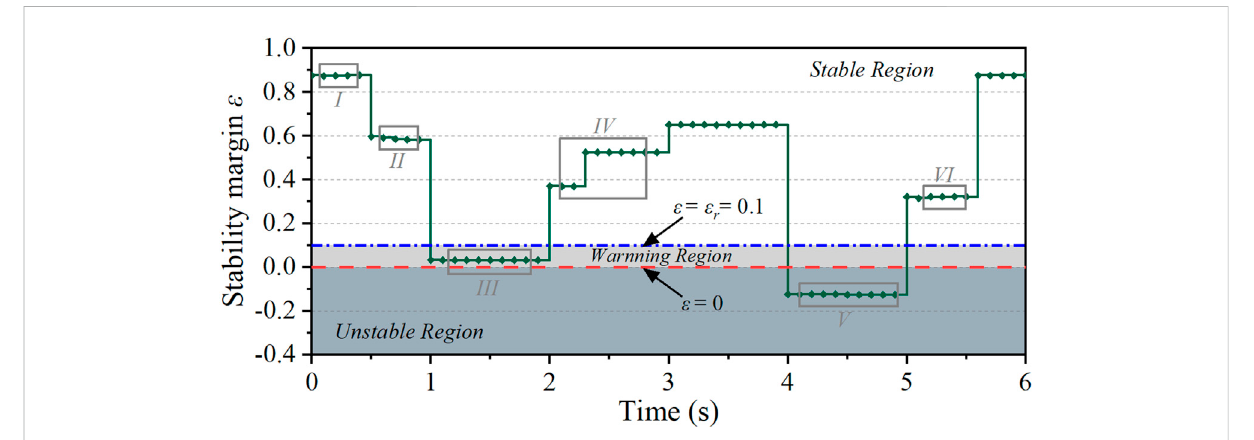
FIGURE 7 The dynamic variation of stability margin during conditions changing.